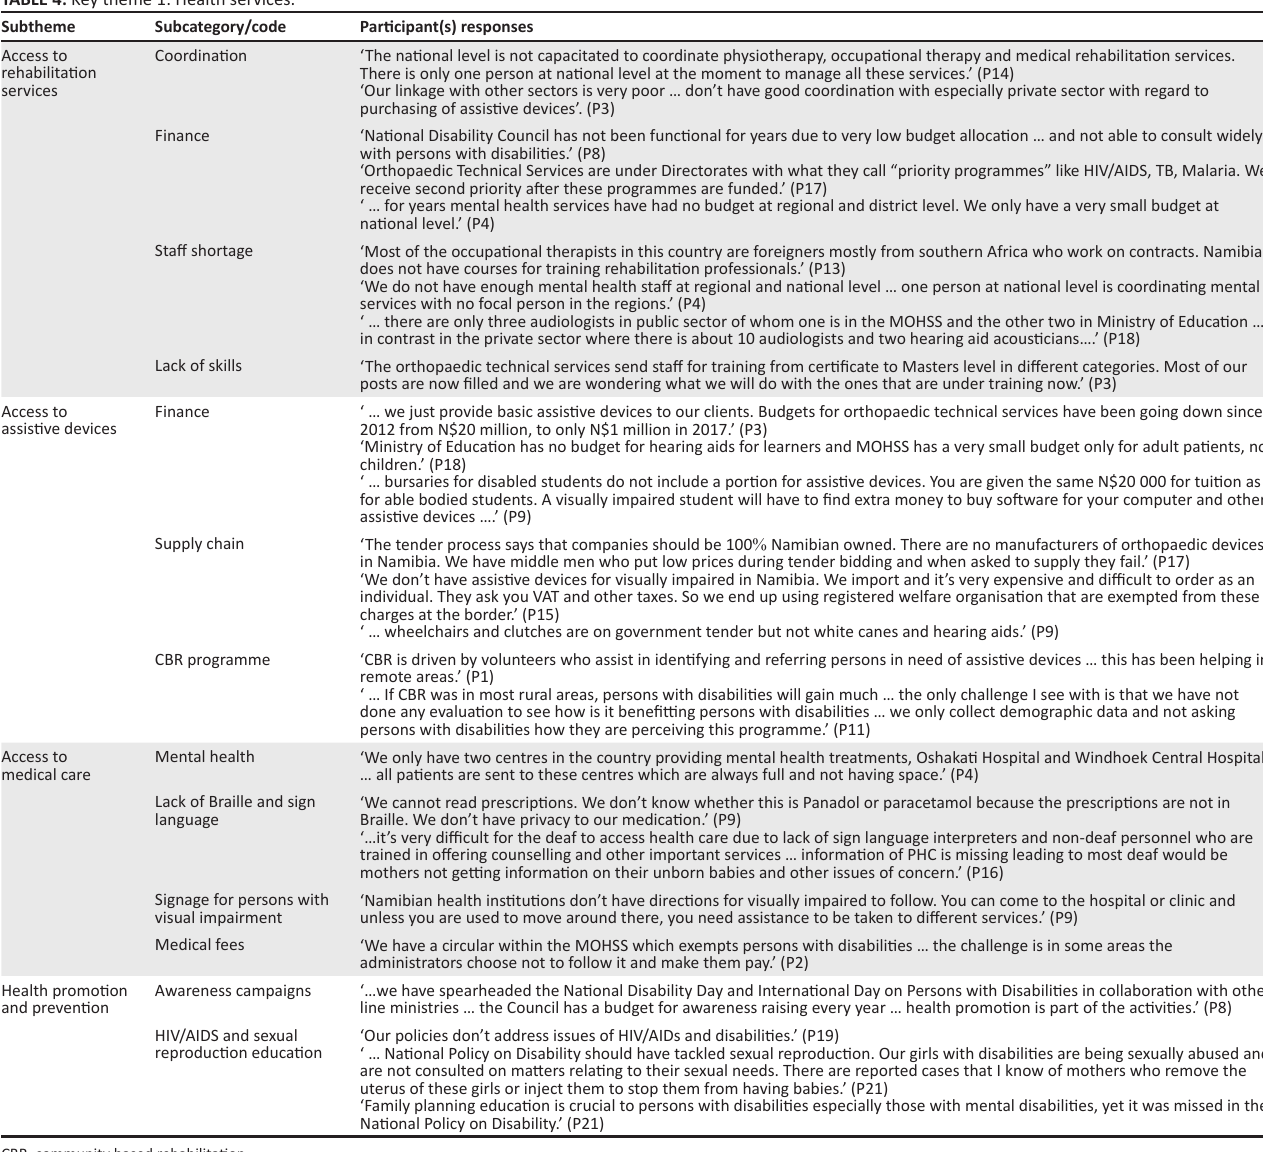
TABLE 4: Key theme 1: Health